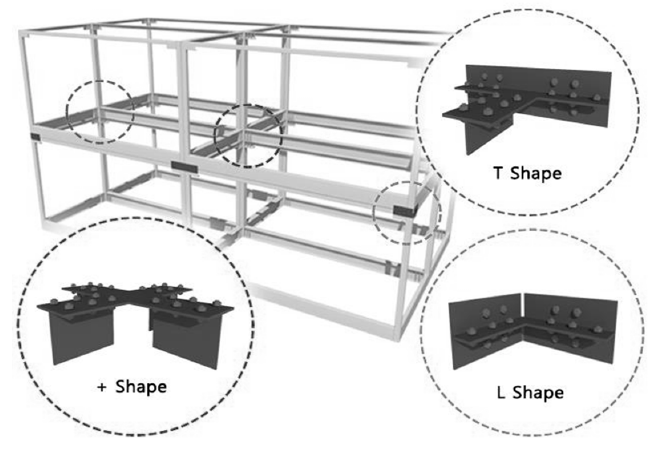
Figure 2. Connection attachment and the modular units.